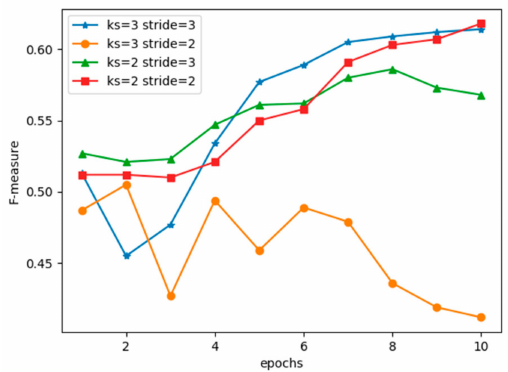
Figure 10. Kernel size and stride. Here ks means kernel